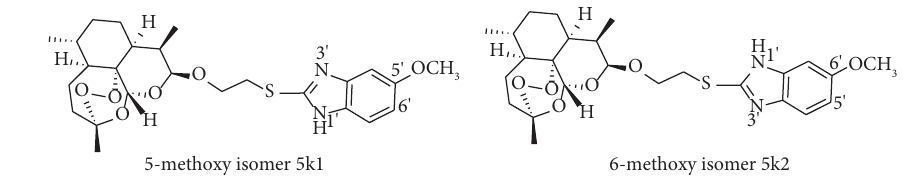
Figure 2: Structures of two isomers 5k1 and 5k2